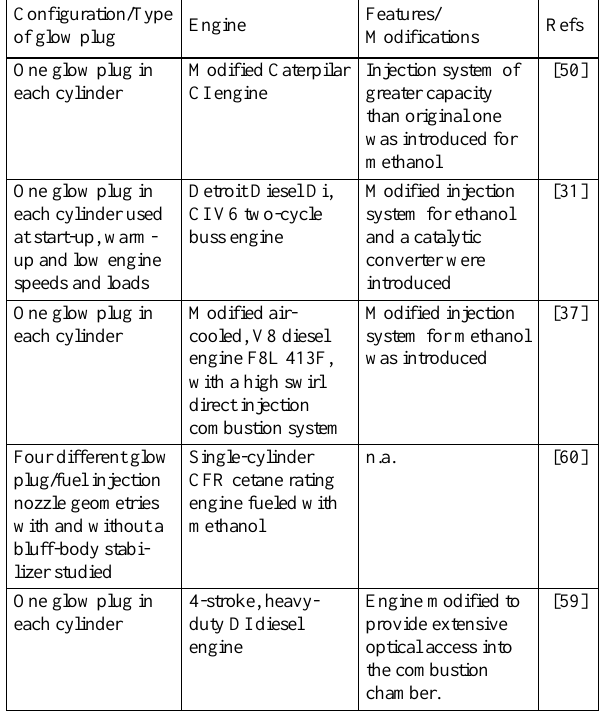
Table 4. The application of glow plugs for engines supplied with